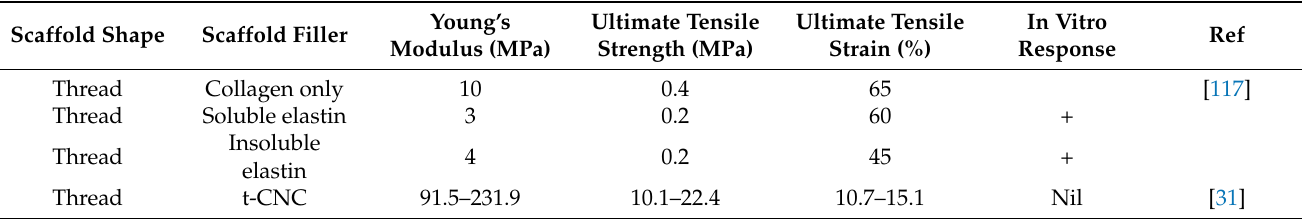
Table 5. Summary table of the fillers utilised for collagen-based